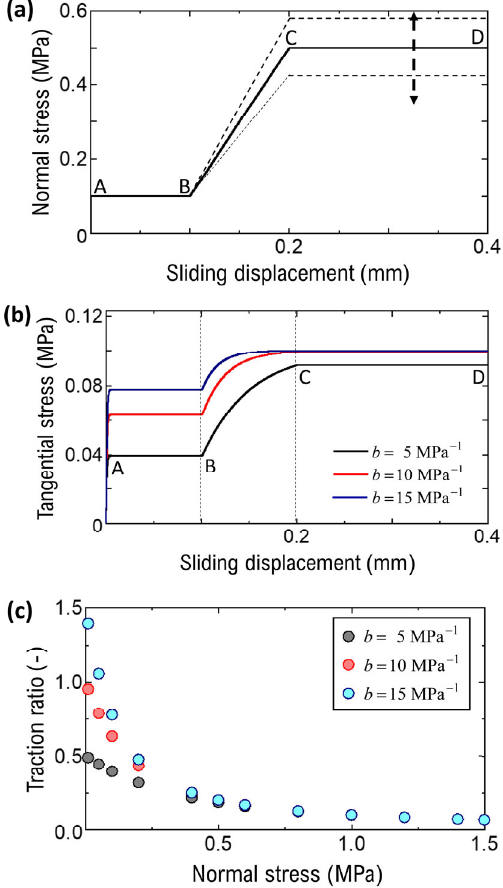
Fig. 6 Typical response of pressure-dependent friction without Fig. 7 Typical response of pressure-dependent friction with rate rate dependency, in the case in which the sliding velocity dependency, for b =10 MPa -1 : (a) variation of tangential stress v is t 1.0 mm/s: (a) an input condition of normal stress, wherein the with sliding under the input condition of Fig. 6(a), in which the steady state value is 0.5 MPa f  ; (b) variation of tangential stress sliding velocity v is 1.0 mm/s; (b) rate- and pressure dependency n t with sliding under the input condition (a), in which the parameter b of friction coefficient under the velocity-weakening regime; was set to have three values; (c) relationship between the traction (c) rate- and pressure dependency of friction coefficient under the ratio (friction coefficient) in steady state and the normal stress. velocity-strengthening